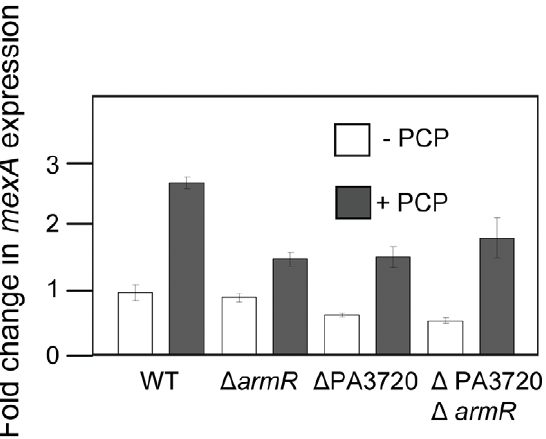
Figure 6. ArmR-/PA3720-independence of PCP induction of mexAB-oprM . Expression of mexA (as a measure of mexAB-oprM ) was assessed in P. aeruginosa strains K767 (wild type; WT), K3145 ( D armR ), K3146 ( D PA3720) and K3130 ( D PA3720- armR ) exposed or not to PCP (0.75 mM; 1.5 hr) using qRT-PCR. Expression was normalized to rpsL controls and is reported relative (fold change) to untreated P. aeruginosa K767. Results shown are the mean + / 2 standard error of one cDNA sample for each, processed in triplicate, and are represen- tative of 2 independent experiments.